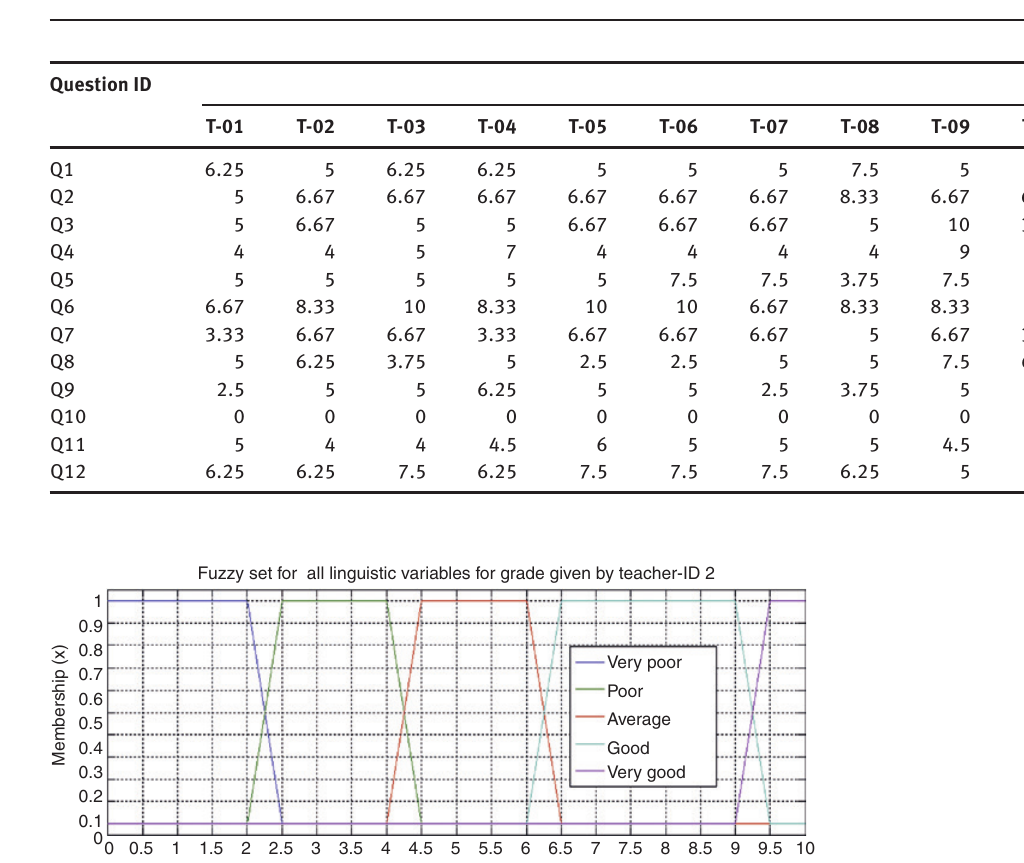
Table 1: Score Data of 12 Answers Attempted by Student ID-02 Rated by 11 Experts.